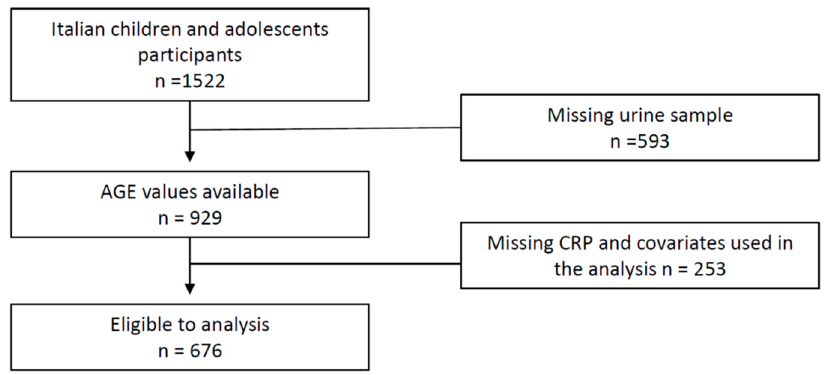
Figure 1. Flow chart of participants included in the final analysis. Registration: The Pan-European IDEFICS/I.Family children cohort is registered under ISRCTN62310987. Date assigned: 23 February